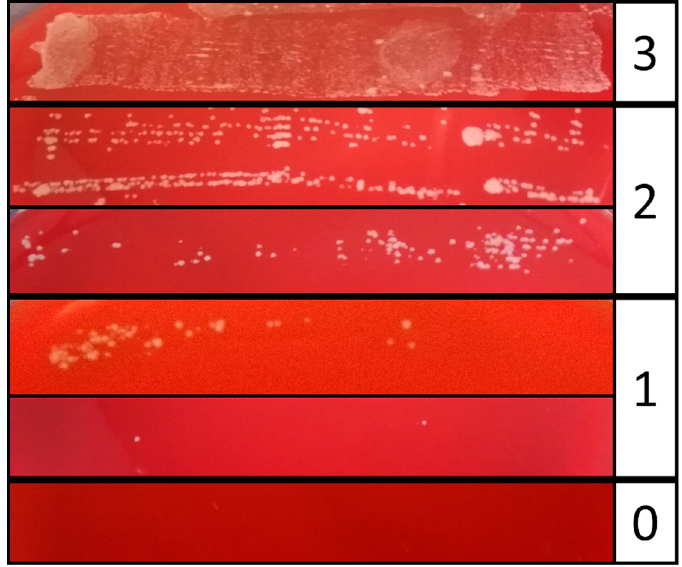
Figure 4. Evaluation scheme for microbial growth. Treated implants were rolled on Columbia Blood Agar plates and incubated at 37 °C. Growth of the individual roll-outs was scored from 0 = no bacterial growth, 1 = minor growth, 2 = major growth, 3 = strong growth.